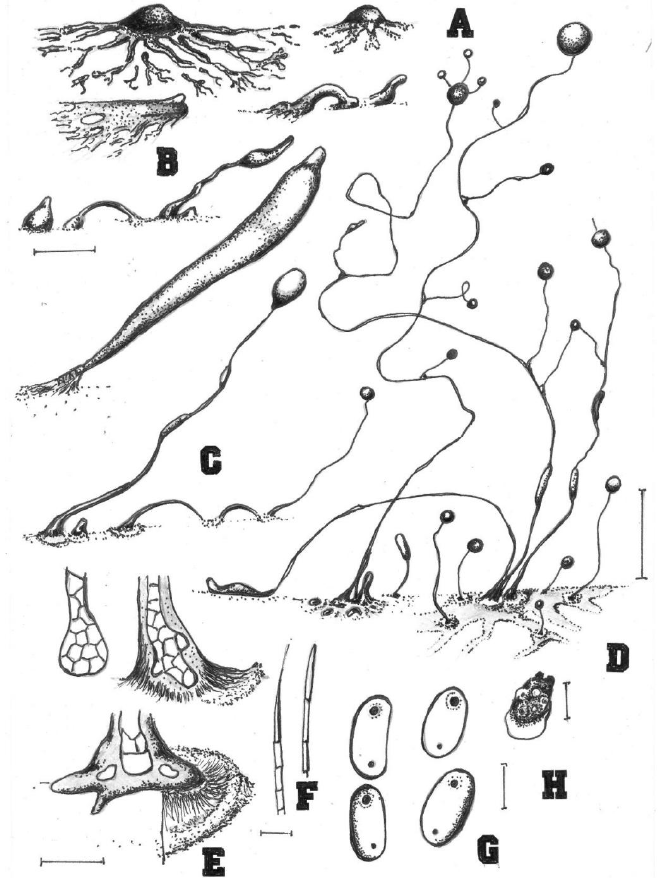
Figure 6. Morphological features of Cavenderia protumula (TH20A). ( A ), Radiate aggregation with partite streams (left); a small aggregation with short blocky streams (right). ( B ), Migrating solitary pseudoplasmodium with flat anastomosed streams (above, left); a stoloniferous migrating early so- rogen (above, right); progression of an early-late solitary migrating sorogen (below, left); a single enlarged early late migrating sorogen with stalk formation at its basal portion (out of scale, below left). ( C ), Late solitary sorogen with masses of ascending pseudoplasmodia and a companion small pseudoplasmodium mass close to the base (left); stoloniferous habit of a solitary sorocarp, basal halo present (right). ( D ), Solitary sigmoid low-branched mature sorocarp with its satellite early sorogen at base, surrounded by small pseudoplasmodial mases (left); clustered sorocarps with small satellite unbranched sorocarps, bases with halos and a trace of the early aggregation remains. Sori refruits, collapse soon or slides down and hang together; a frequent stoloniferous habit. ( E ), Round base (above, left); shortly digitate base with abundant mucilage sheath, a basal ring, or halo (above, right); young base terminating in a single larger cell, the slime is densely abundant and the sheath pro- longed until the elevated ring or halo (below). ( F ), Piliform (left) and simple narrowed one-celled tip (right). ( G ), Short regular spores with polar to subpolar compound granules, some with halos. ( H ), Myxamoeba. Bars: ( A , B ) = 200 μ m; ( C , D ) = 0.5 mm; ( E ) = 25 μ m; ( F ) = 10 μ m; ( G ) = 5 μ m; ( H ) = 10 μ m.